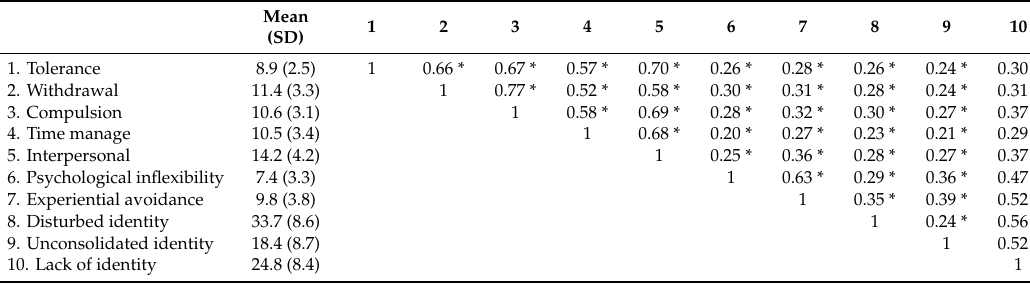
Table 1. The correlation matric of measured variables.